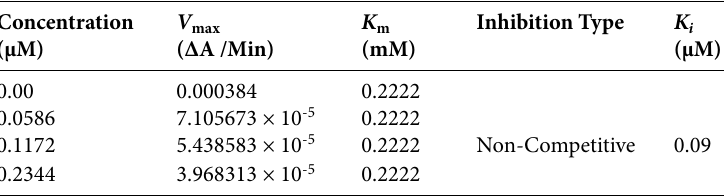
Table 2. Kinetic parameters of the mushroom tyrosinase for L-DOPA activity in the presence of various concentrations of compound 5.